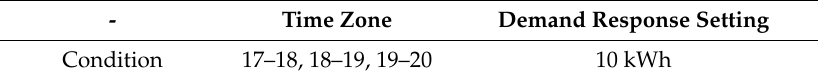
Table 8. Demand response operating condition.